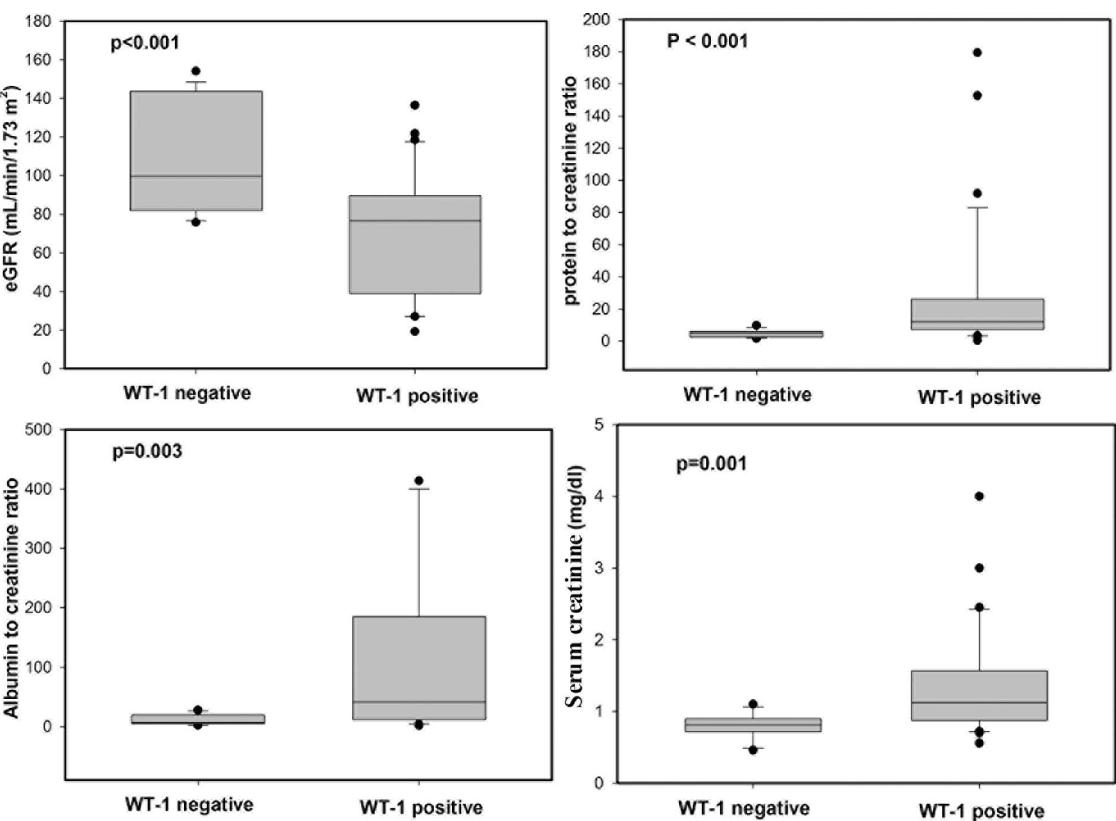
Figure 3. Comparison of renal function parameters between WT1 positive and WT1 negative diabetic subjects. Box plots comparing; A) Estimated GFR; B) Urine protein-to- creatinine ratio; C) Urine albumin-to-creatinine ratio; and D) serum Creatinine levels between WT1 positive and WT1 negative diabetic patients. The boxes indicate median and 25th and 75th percentiles; Outliers are indicated by closed dots. Data were compared by the Mann-Whitney U test. p , 0.05 was considered significant.